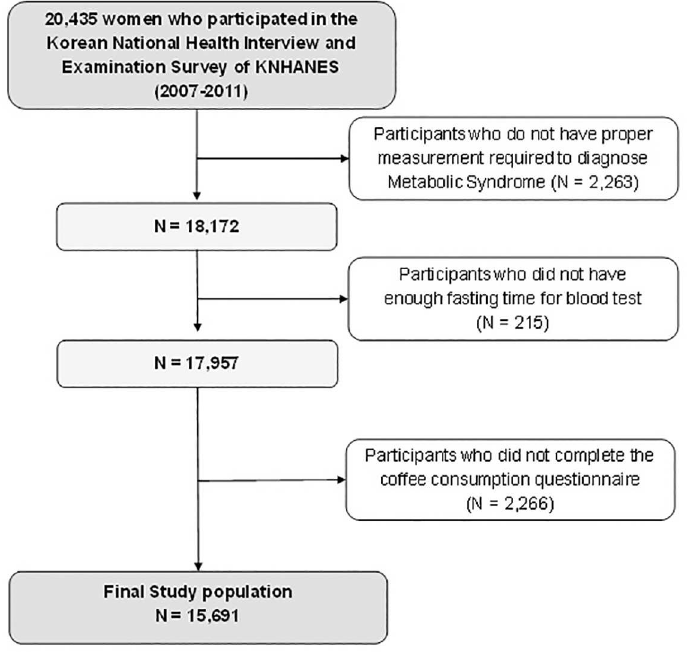
Fig 1. The subjects eligible for study after the exclusion criteria: The Fourth and Fifth Korean National Health and Nutritional Examination Survey. (2007–2011).